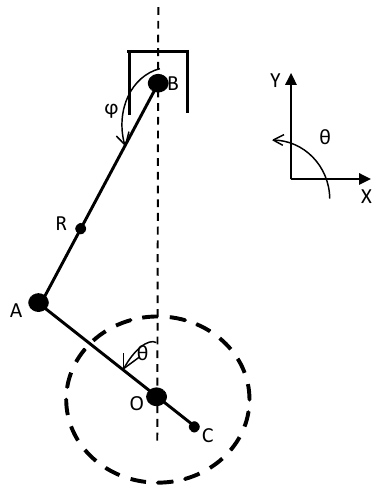
Figure 2. The simple model of piston, crankshaft, and transmission rod.